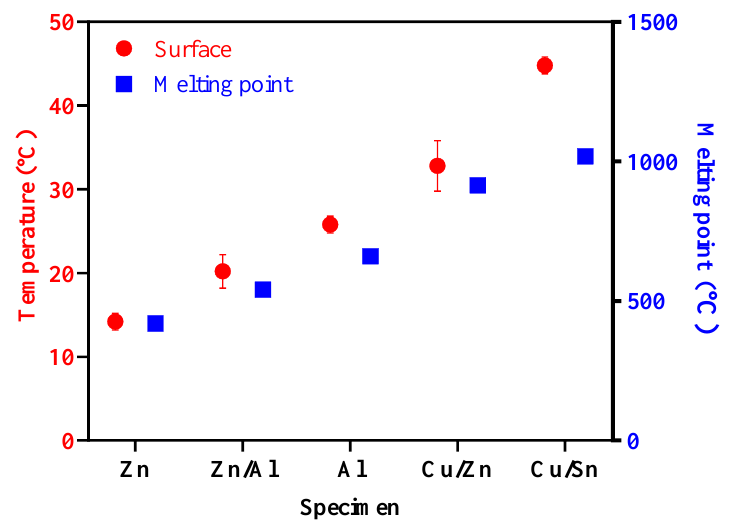
Figure 7. Surface temperature and melting point.